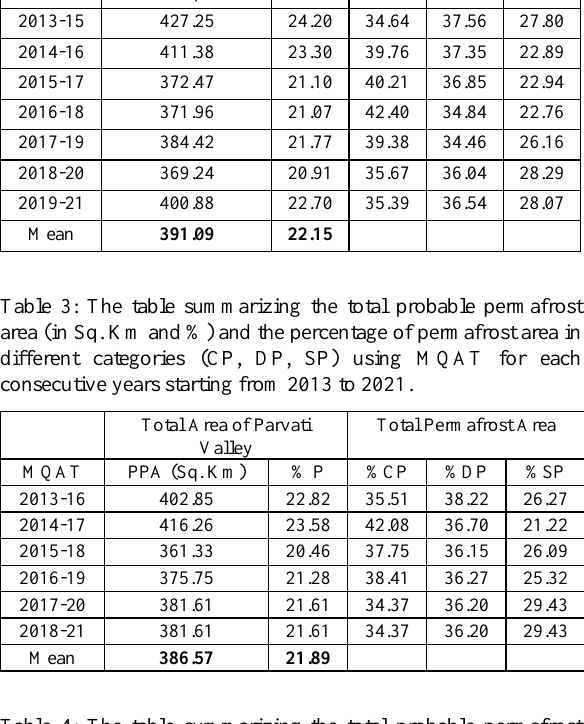
Table 4: The table summarizing the total probable permafrost area (in Sq. Km and %) and the percentage of permafrost area in different categories (CP, DP, SP) using MQnAT for each consecutive years starting from 2013 to 2021.